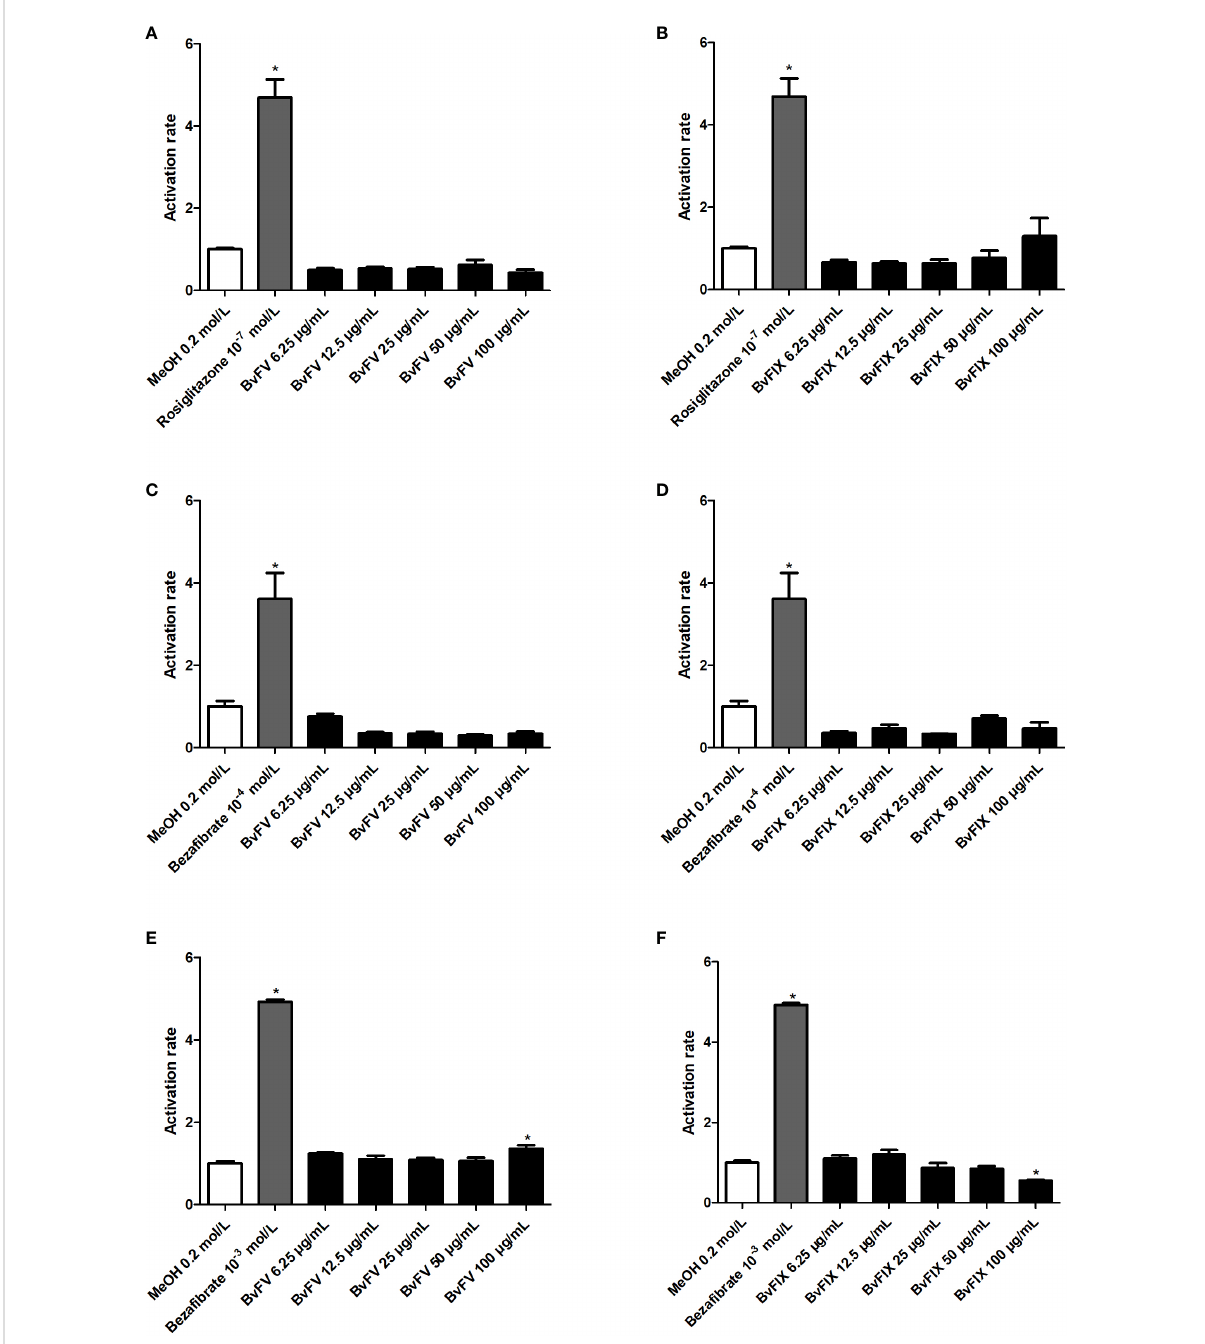
FIGURE 5 Evaluation of agonist activity of extracts against PPAR receptor. HeLa cells were treated for 22 h with different concentrations of extracts, with the solvent used to solubilize the samples (MeOH – negative control) only or with a PPAR agonist (positive control). The results presented represent the mean ± S.E.M of the PPAR activation rate. (A) PPAR g - BvFV, (B) PPAR g - BvFIX, (C) PPAR a - BvFV, (D) PPAR a - BvFIX, (E) PPAR b / d - BvFV, and (F) PPAR b / d - BvFIX. The statistical test applied was the analysis of variance (one-way ANOVA) followed by Dunnett ’ s test. *, p < 0.05 vs. MeOH (0.2